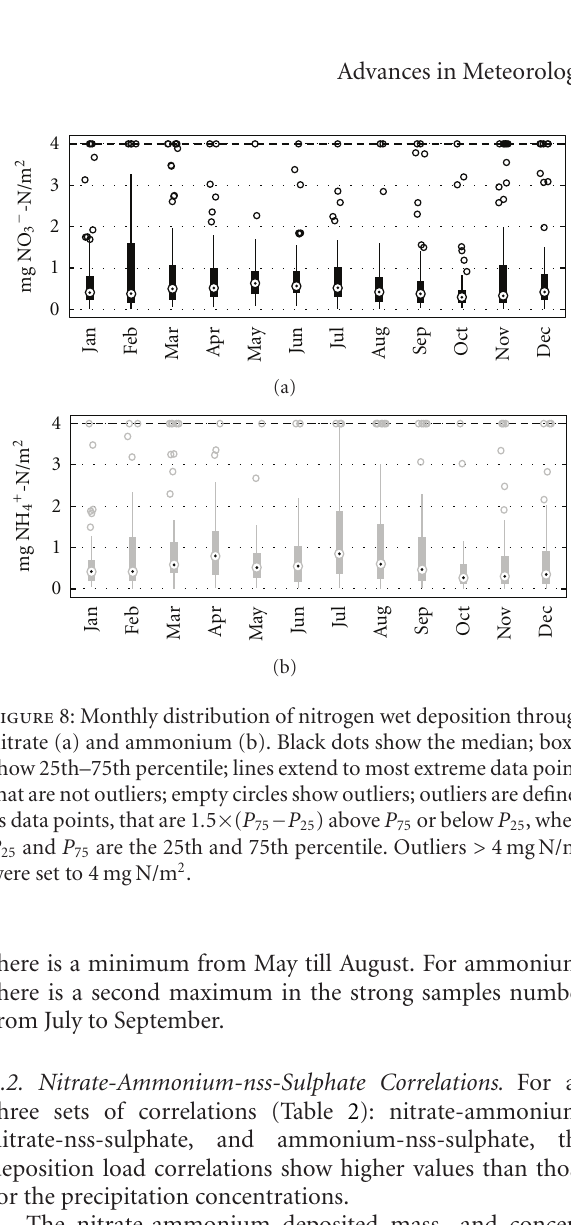
Figure 7: Annual budgets for wet deposition of sulphur through non-sea-salt sulphate. Wide bars: solid precipitation season; narrow bars: liquid precipitation season.